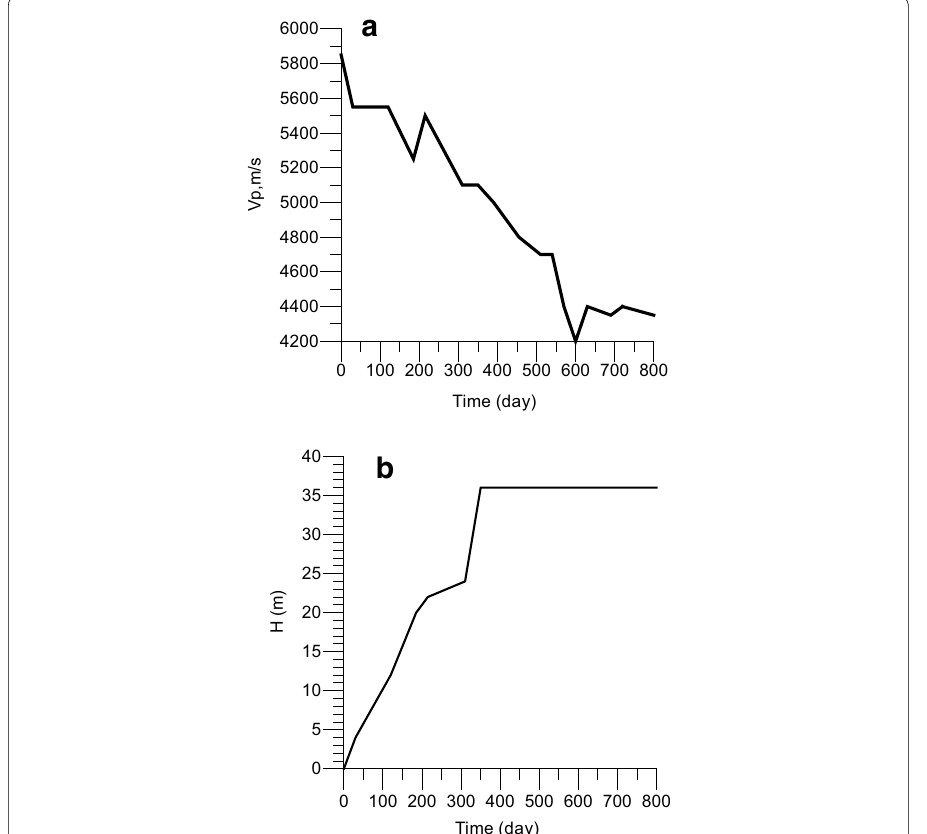
Fig. 12 Average velocity Vp ( a ) and distance of the drill hole to MH bottom ( b ) versus time